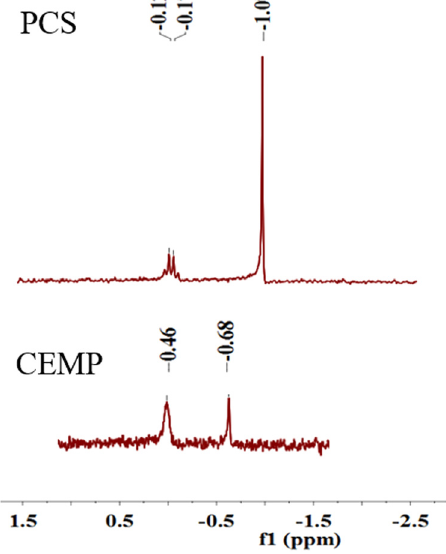
Figure 3: 31 P NMR spectra of PCS and CEMP. Figure 4: SEM photographs of CS, melamine, and